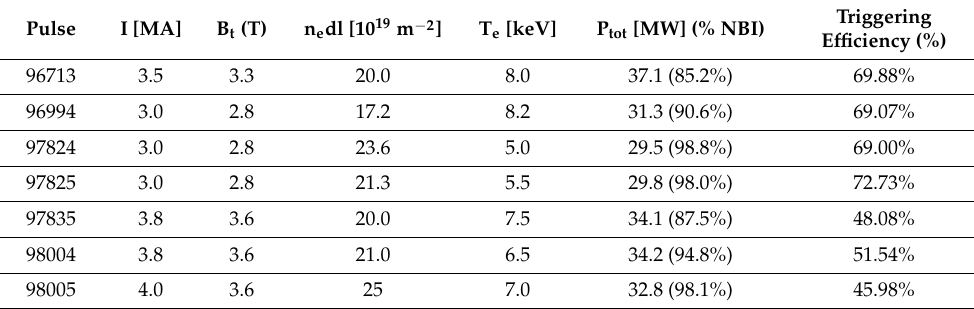
Table 1. Pulses analysed with the SPCC clustering